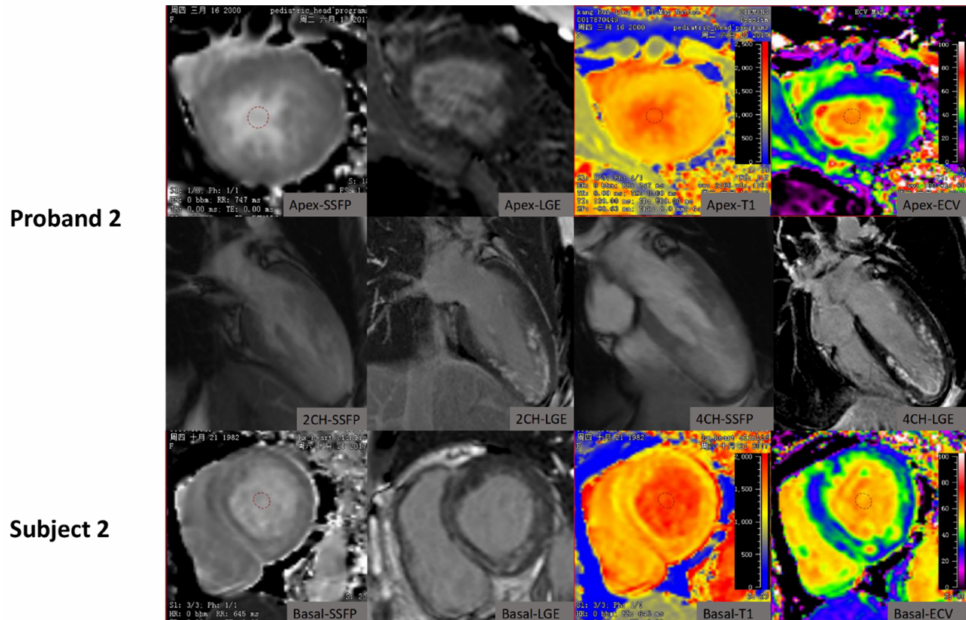
Figure 2. The characteristics of cardiac MRI in the proband 2 patient and the patient’s mother (Subject 2) with Danon disease.